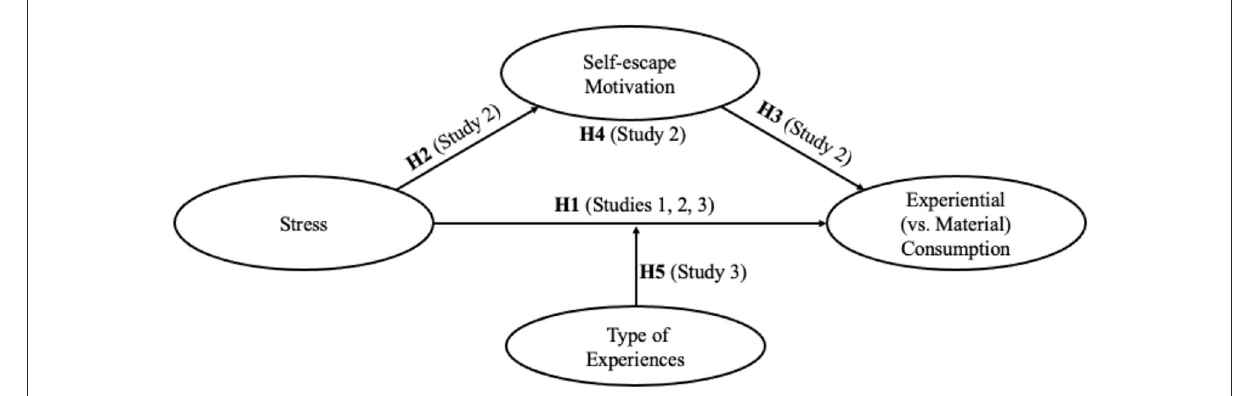
FIGURE1 Conceptual framework and outline of the studies and